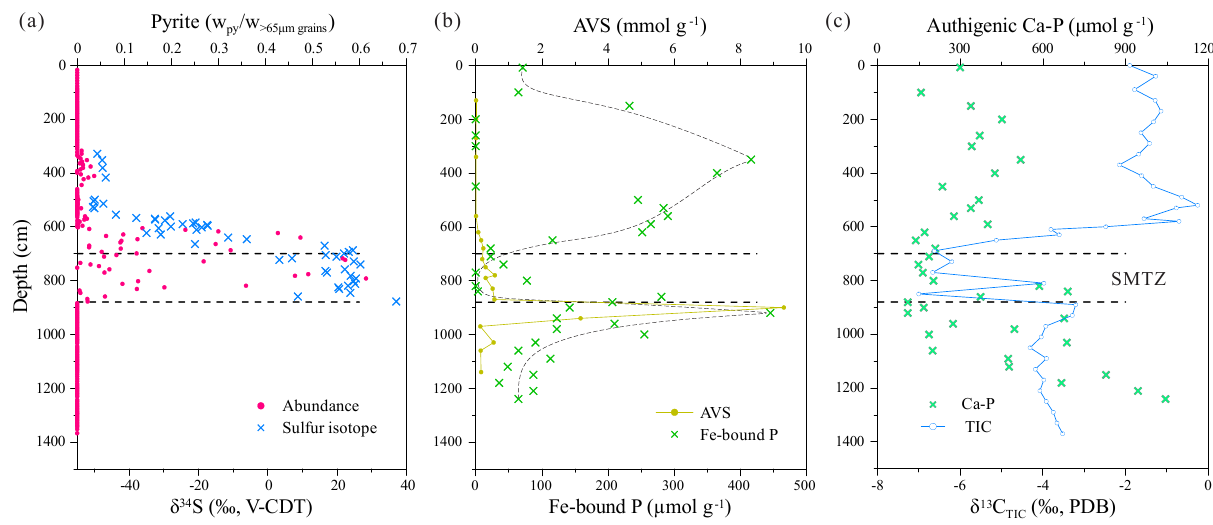
Figure 9. Depth profiles of (a) handpicked pyrite abundance and sulfur isotopic composition (Lin et al., 2015), (b) acid volatile sulfur (AVS) and Fe-bound P (J. Zhang et al., 2014, 2018a), and (c) authigenic Ca–P and carbon isotopic composition of total inorganic carbon (TIC) (Ou, 2013; J. Zhang et al., 2018a,